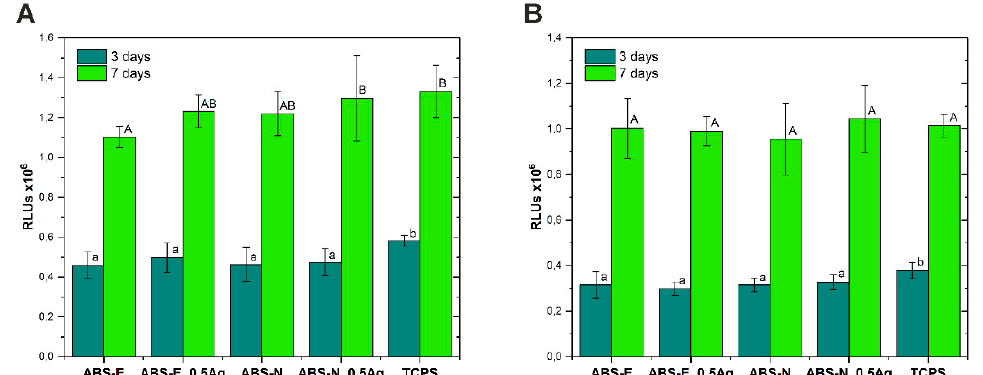
Figure 6. The relative number of Saos-2 ( A ) and Hs680.Tr ( B ) cells after 3 and 7 days of culture in direct contact with the tested materials in the ToxiLight test. The results are presented as mean values ± standard deviation. Statistically significant differences ( p < 0.05) between the tested materials are marked a-b for 3-day culture and A-B for 7-day culture.